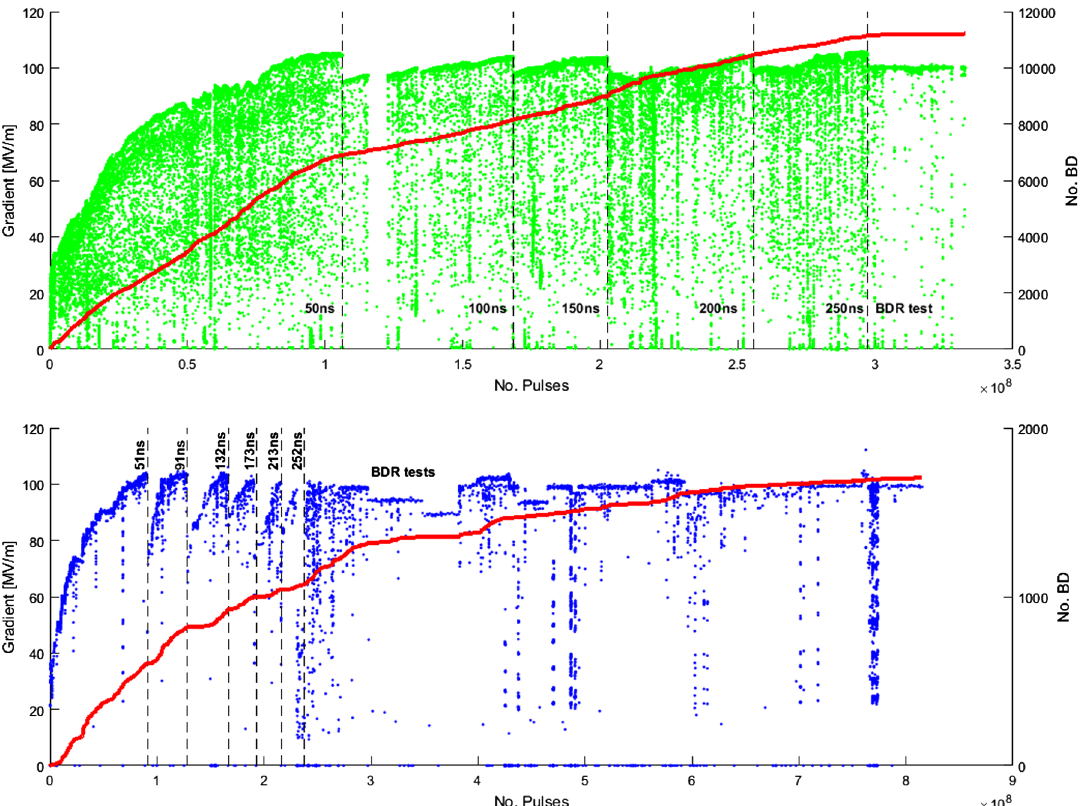
FIG. 1. Summary of CERN TD26CC and KEK TD24R05#4 raw data. The green and blue dots represent the unloaded gradient (left axis) excited into the structure as a function of the number of pulses. The red solid line indicates the cumulated number of breakdowns (right axis). The dots that fall below the envelope are due to the power ramping applied after a breakdown event. For the rest of the analysis these points have been discarded. The changes in pulse widths are indicated by vertical lines.